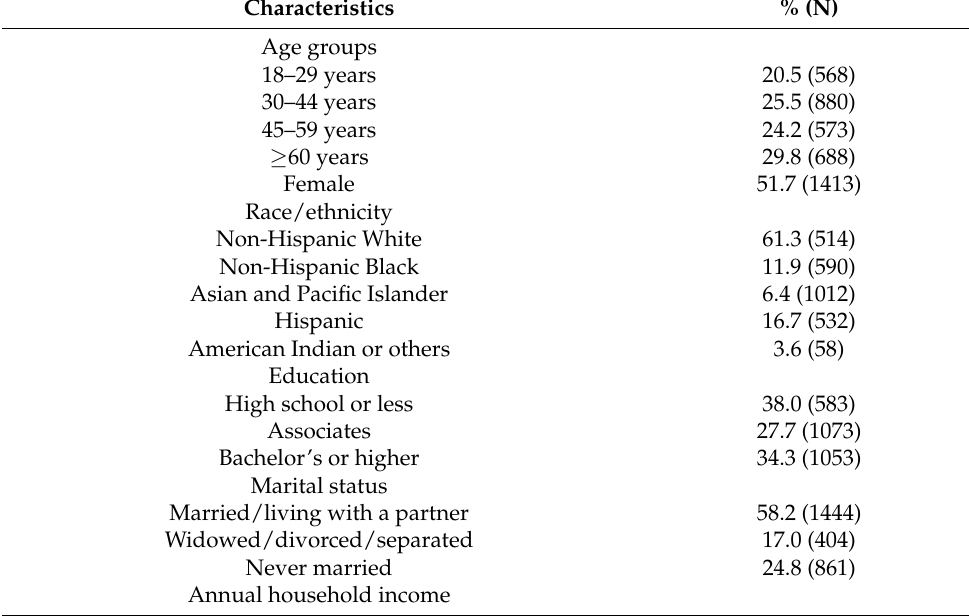
Table 1. Sociodemographic characteristics of HEAP study